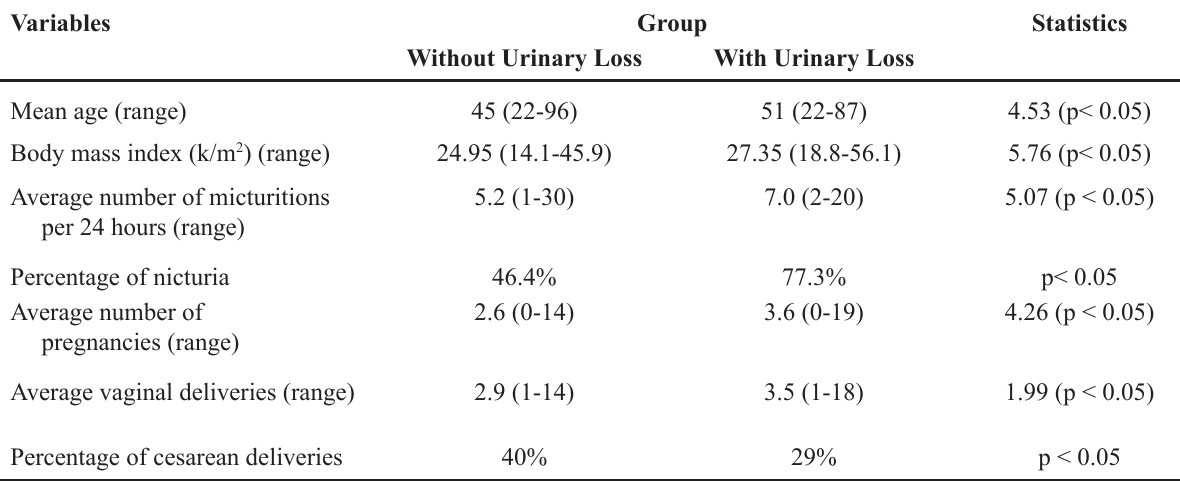
Table 1 – Demographic characteristics of 685 subjects interviewed.